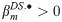
Power comparison between CCRET and PLINK 1-sided tests for simulation I-A: between-locus heterogeneity of the dosage simulation.As detailed in section “Simulation Design”, we considered 6 heterogeneity models with different proportions of risk-associated (βmDS.•>0) or protective (βmDS.•<0) effects among causal loci. Black O line: CCRET; Blue Δ: PLINK 1-sided test analyzing deletions and duplications combined; Green +: PLINK 1-sided test analyzing only duplications; Magenta x: PLINK 1-sided test analyzing only deletions.